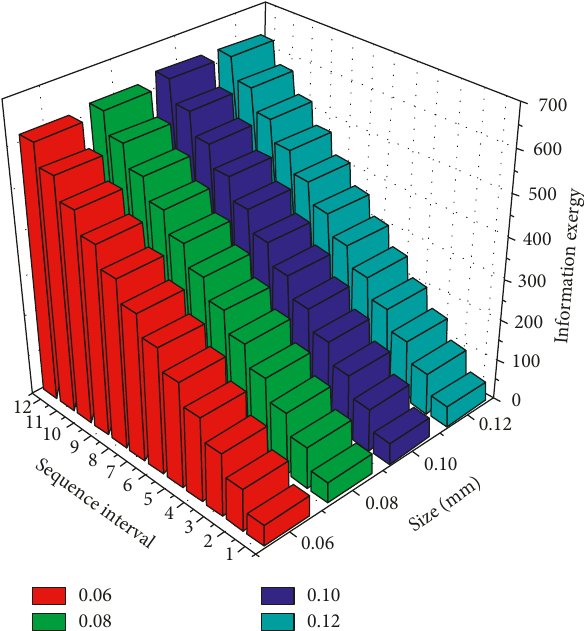
Figure 4: Information exergy of different fault sizes.